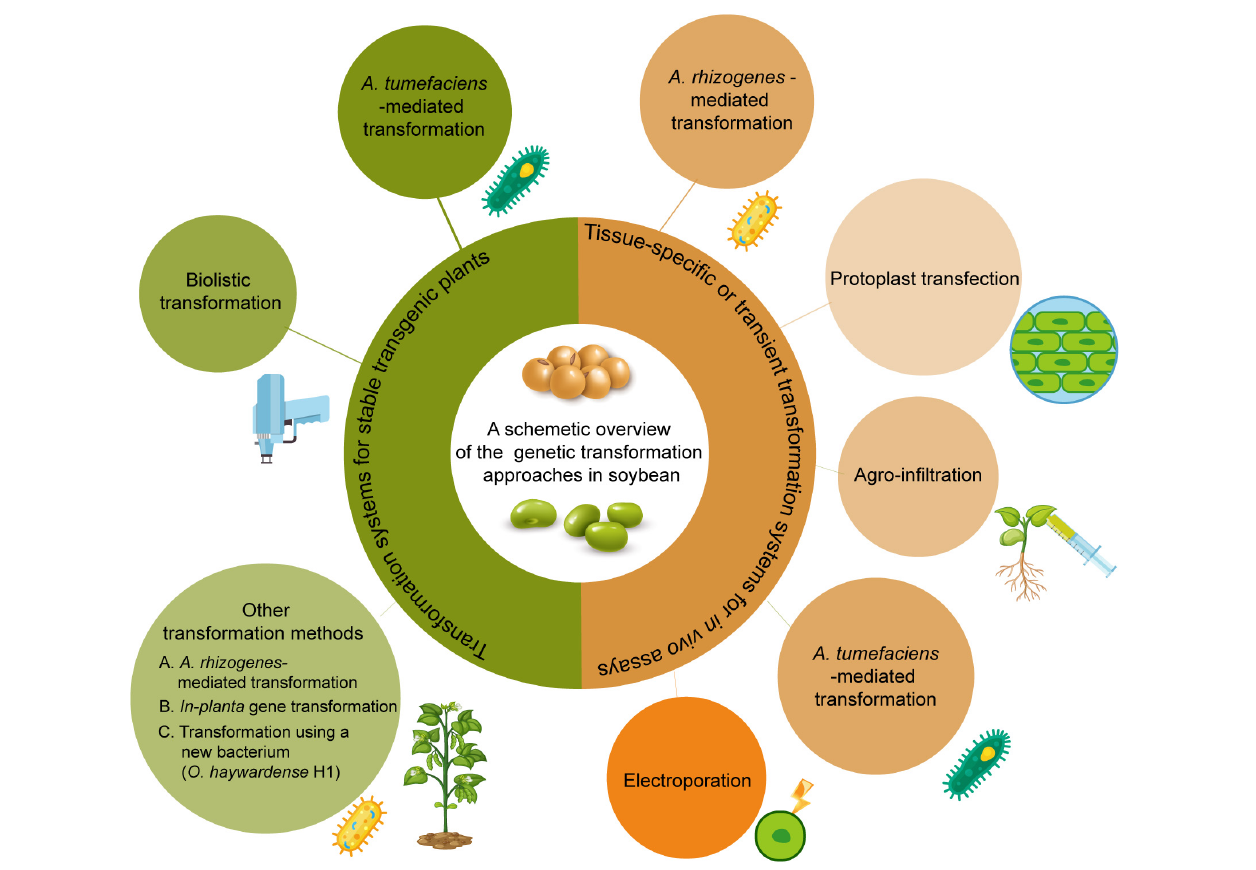
FIGURE 1 | Current available genetic transformation methods for soybean. The left part with greenish color shows transformation methods to produce stable whole plants. The right part with yellowish color shows transformation methods for transient assay.